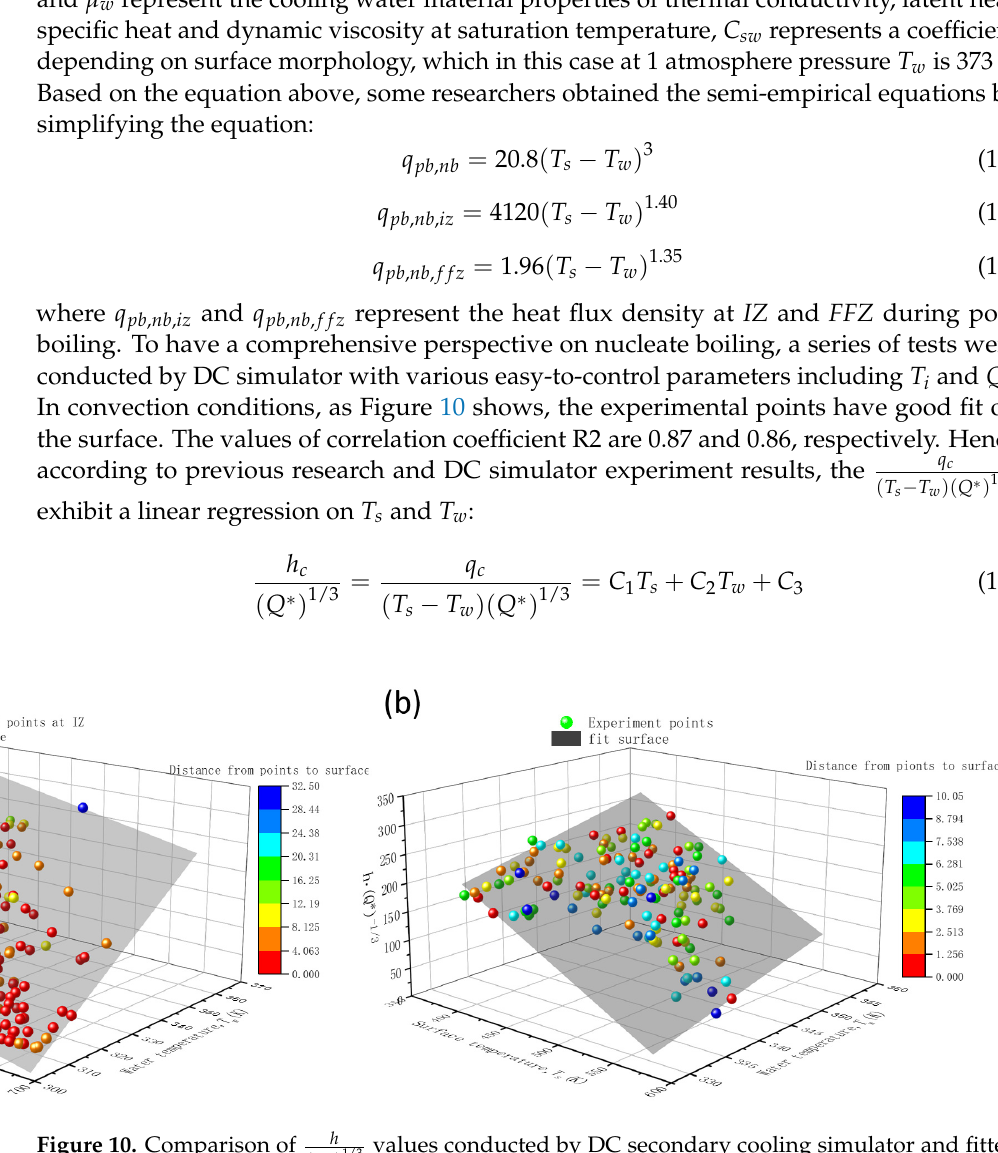
Figure 11. Correlation between data calculated based on Equation (19) and the data gained by DC secondary cooling simulator: ( a ) different 𝑇 (cid:3036) at 473, 523, 573, 623, 673 K, respec- tively, at 60 L min − 1 m − 1 ; ( b ) different 𝑄 ∗ at 20, 40, 60, 80, 100 L min − 1 m − 1 at 673 K.